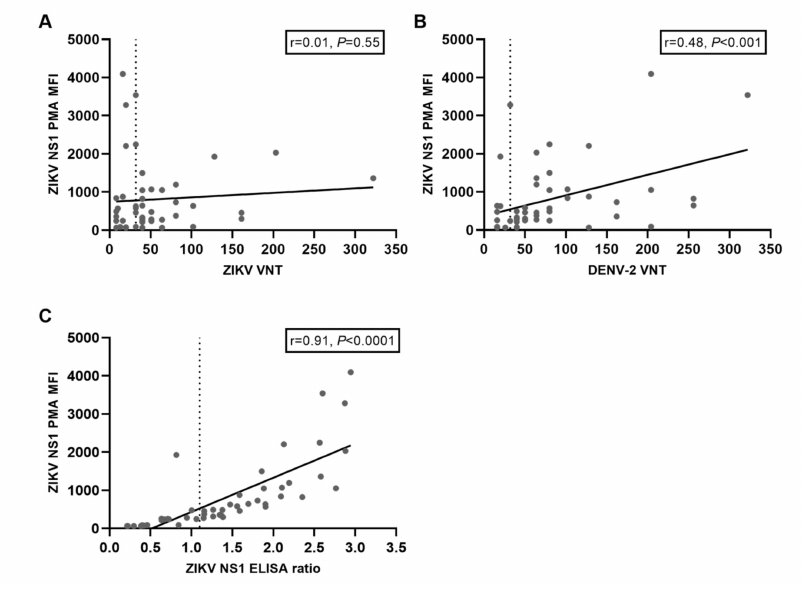
Figure A1. Correlations between ZIKV NS1 IgG titers determined with a protein microarray